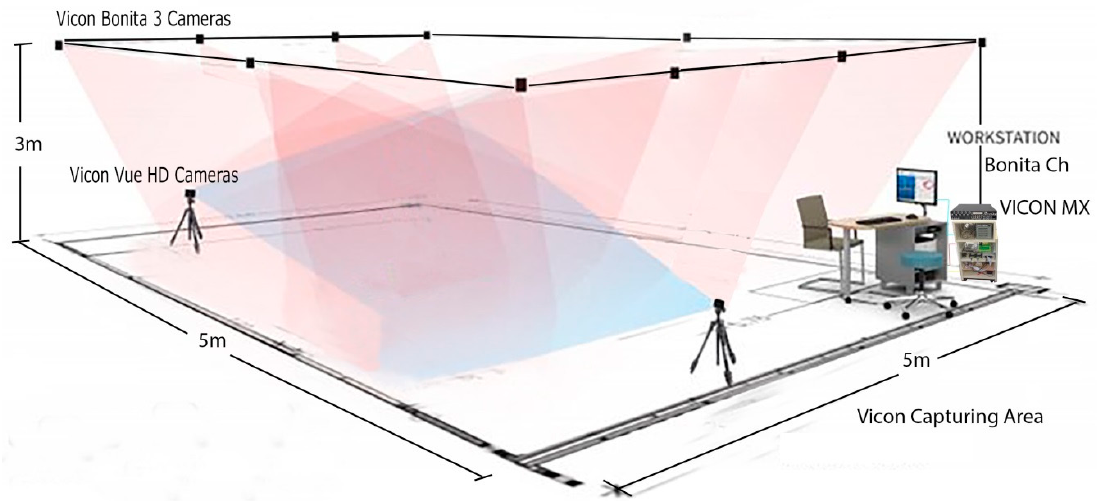
Figure 2. Vicon system capturing area.